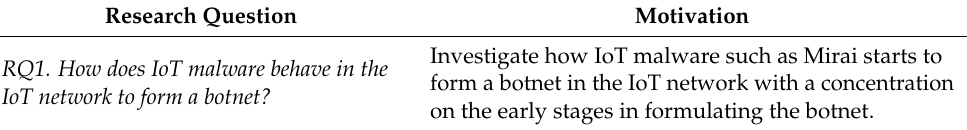
Table 1. The research